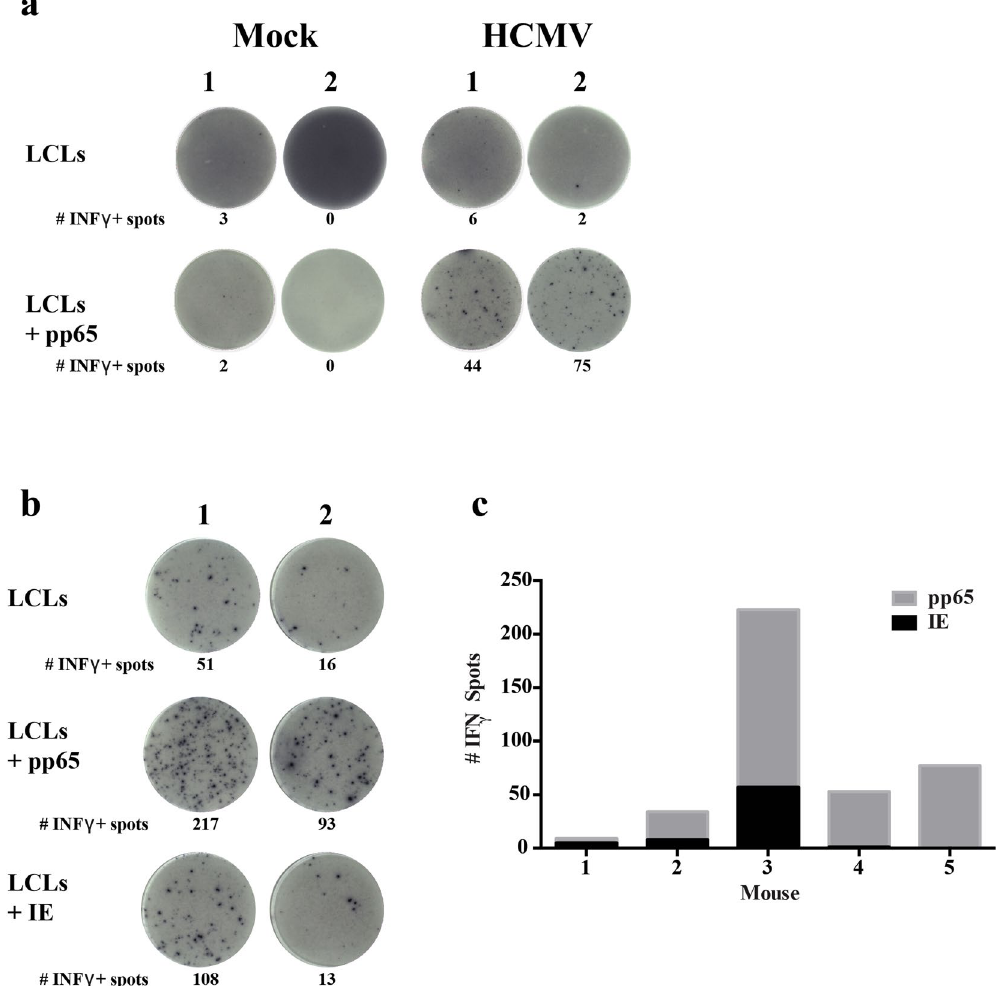
Figure 5. BLT Mice Generate Human IFN γ T-cell Responses Specific to HCMV pp65 and IE. ( a ) huBLT mice were generated and infected with HCMV as in Fig. 1, harvested at 6–8 weeks post-infection and splenic mononuclear cells isolated using Ficoll. Isolated splenocytes from two independent cohorts of huBLT mice were cultured with autologous LCLs alone or LCLs pre-loaded with HCMV pp65 peptides and cultured on human IFN γ ELISpot plates (MabTech) prior to detection. To determine the diversity of the HCMV-specific response, additional mice from one cohort of huBLT mice were analyzed for human IFN γ production in response to stimulation with LCLs presenting HCMV pp65 or IE. Two mice are shown in ( b ) and five mice are quantified in ( c